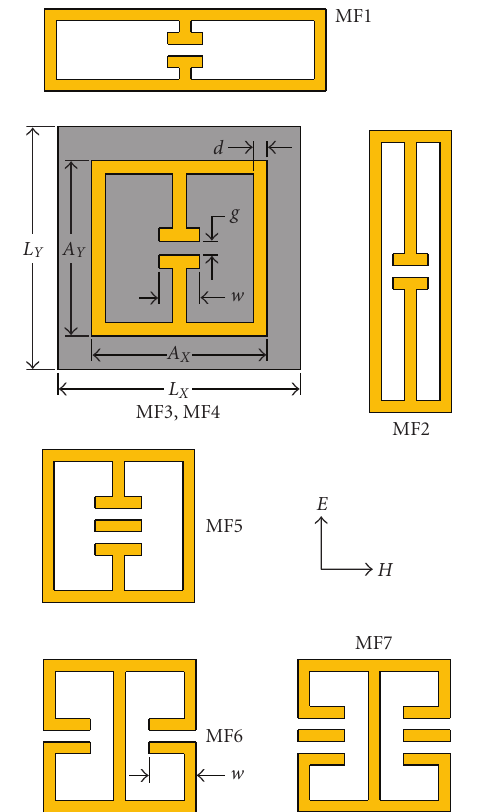
Figure 1: Metafilm unit cells. The dimensions L X and L Y specify the X and Y lattice parameters of the rectangular array on which the unit cells are distributed. Gold color indicates metallized regions whereas gray color indicates bare SI-GaAs regions. The THz field polarization is specified by the arrows to the right of MF5. All draw- ings are shown to scale except for the unit cell representing MF3 and MF4. To clarify dimensioning, this cell was magnified by